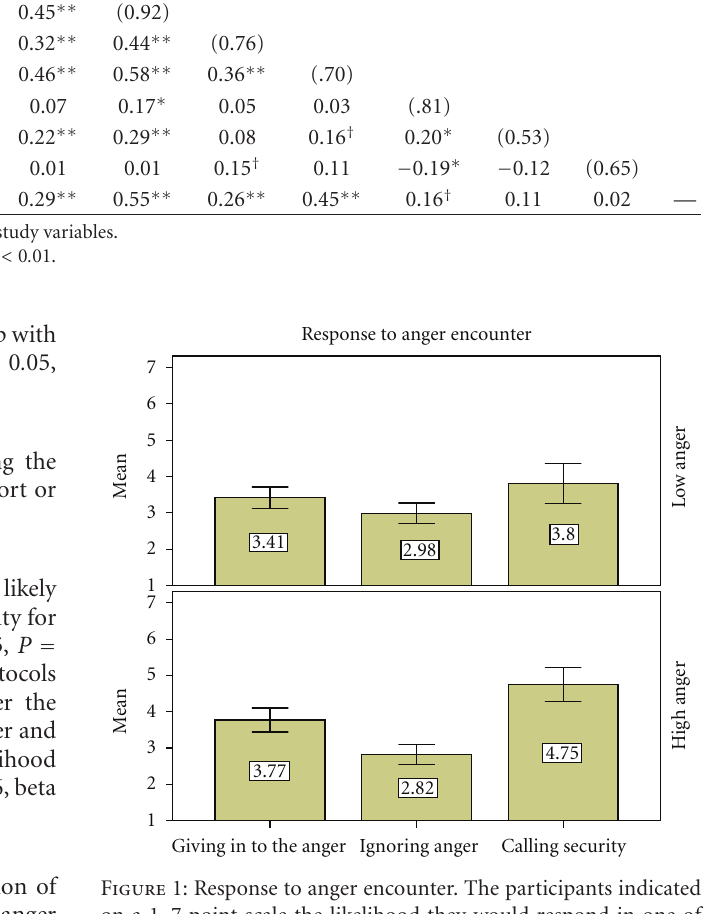
P < 0 . 001, beta anger and frustration = 0.21, P = 0 . 02, beta policy = 0.11,